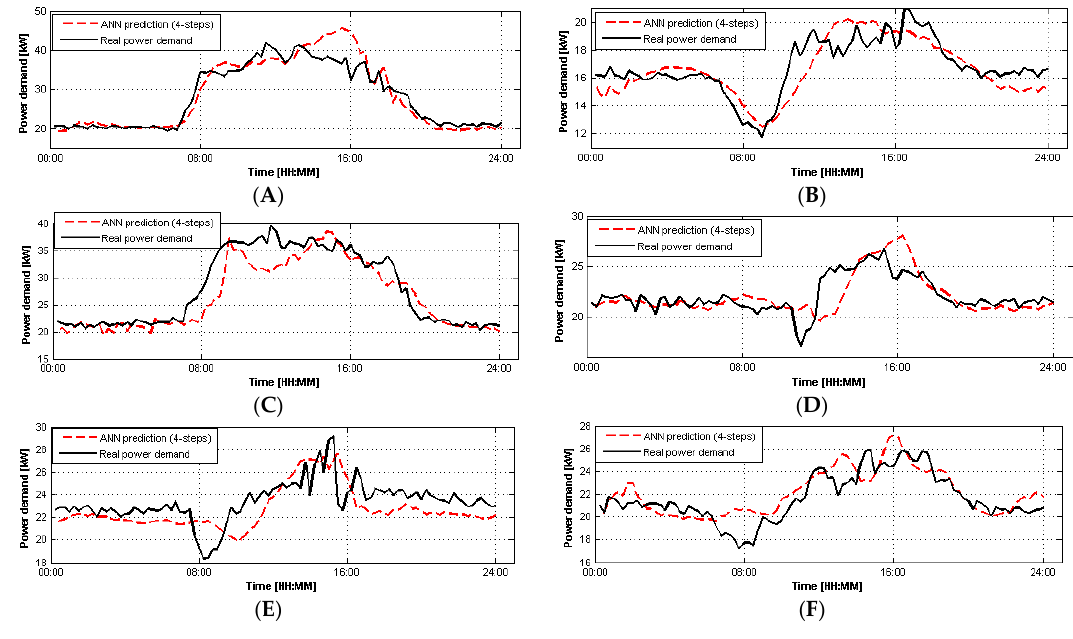
Figure 9. Prediction results for tests ( A – F ) using model I.